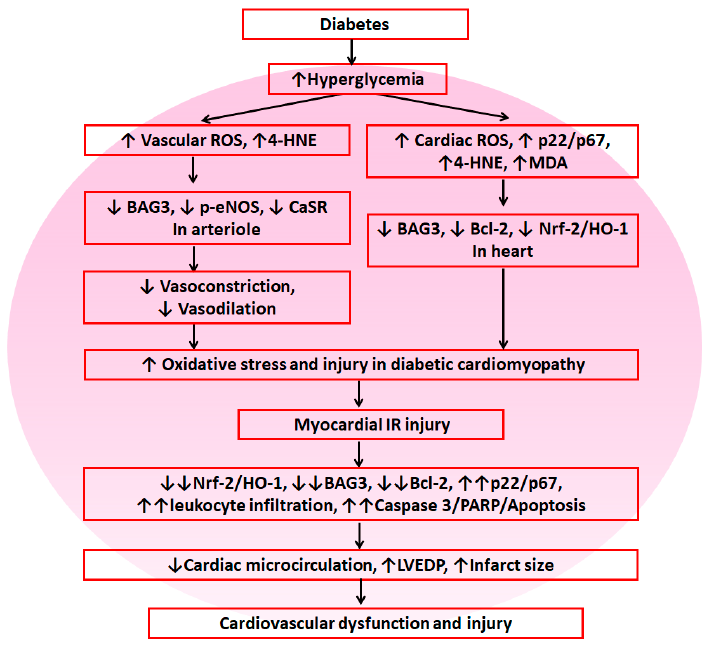
Figure 8. The summary diagram is demonstrated. Diabetes enhanced cardiovascular damage by suppression of antioxidant defense mechanisms including Nrf-2/HO-1, BAG3 and Bcl-2 and increased oxidative stress including vascular and cardiac reactive oxygen species (ROS). In response to myocardial IR injury, diabetes further decreased antioxidant defense mechanisms and enhanced oxidative stress/injury, leading to cardiovascular dysfunction and injury.